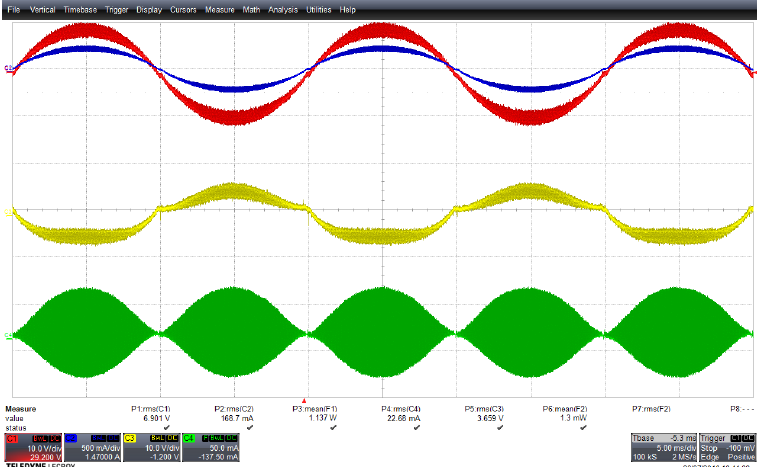
Figure 17. Experimental results of the basic CSI solution. From top to bottom trace: output voltage (red trace, 10 V/div), output current (blue trace, 500 mA/div), ground voltage (yellow trace, 10 V/div), and ground leakage current (green trace, 50 mA/div). c (cid:13) 2016 IEEE [12].